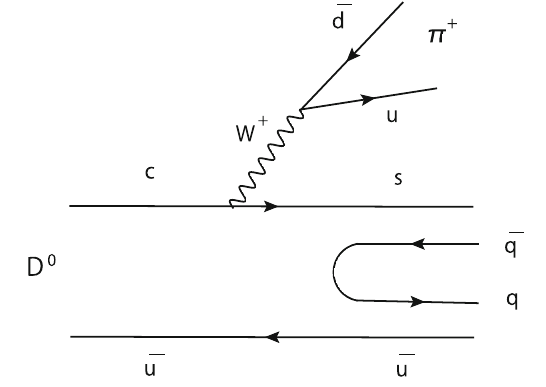
Fig. 1 External emission of D 0 creating a π + and a s ¯ u pair, followed by hadronization of the s ¯ u